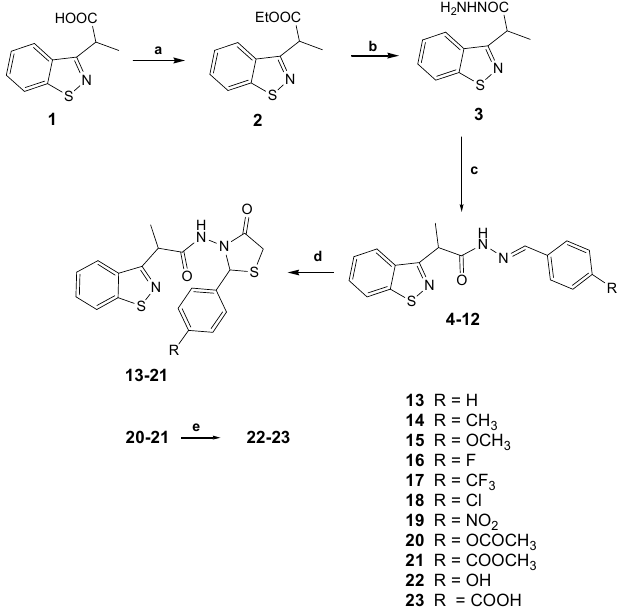
Scheme 1. General procedure for the synthesis of compounds 1 – 23 . General procedure for the synthesis of compounds 1 – 23 . Reagents and conditions : (a) conc. H 2 SO 4 , EtOH, reflux, 8 h; (b) NH 2 NH 2 ,